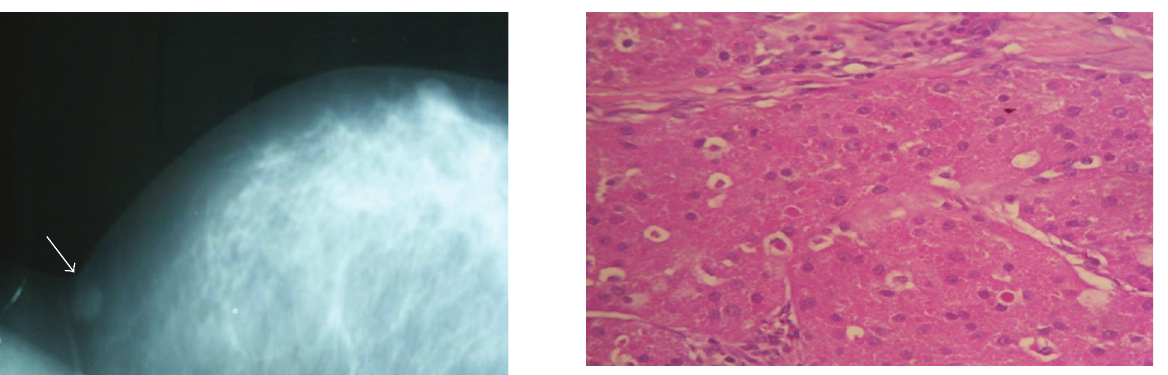
Figure 1: Mass in the axillary tail of the left breast (mammographic image).